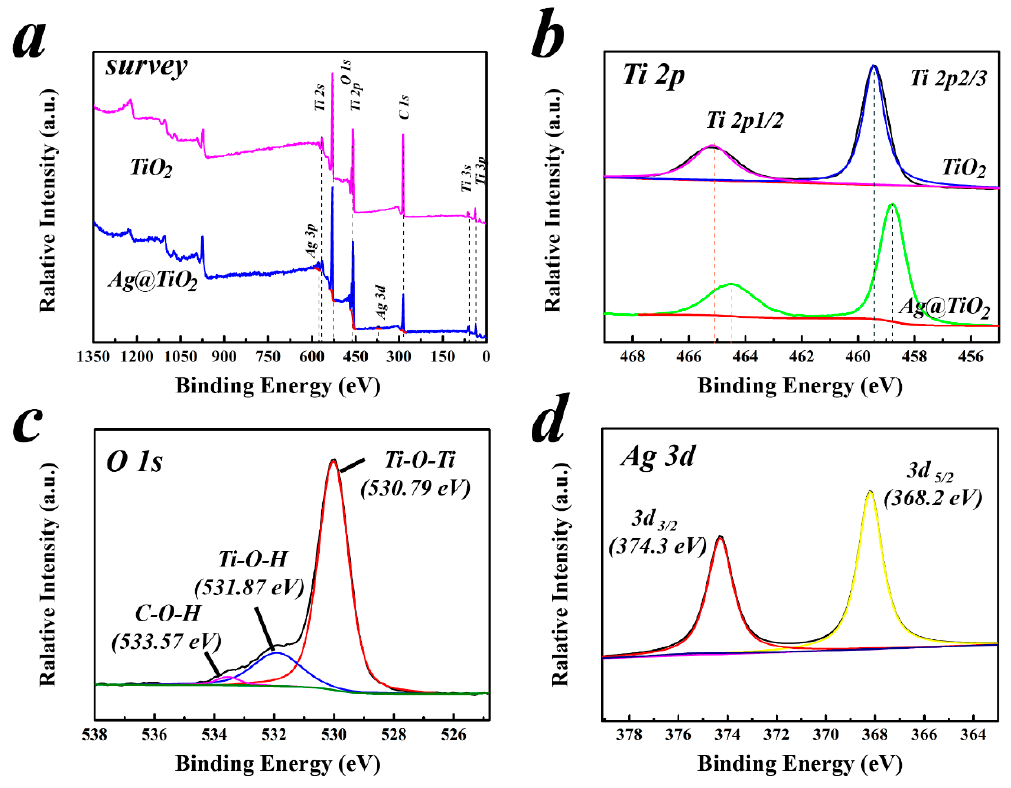
Figure 9. The survey spectrum ( a ); Ti 2p ( b ), O 1s ( c ), and Ag 3d ( d ) XPS spectra of the Ag@TiO 2 composites (0.6 wt %, 30 min irradiation).